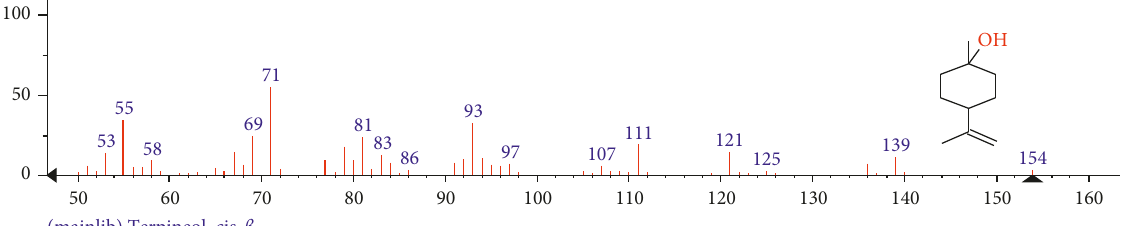
Figure 3: Mass spectrum of compound terpineol, cis- β - of whole plant hexane fraction of Achillea wilhelmsii (WHFAW).